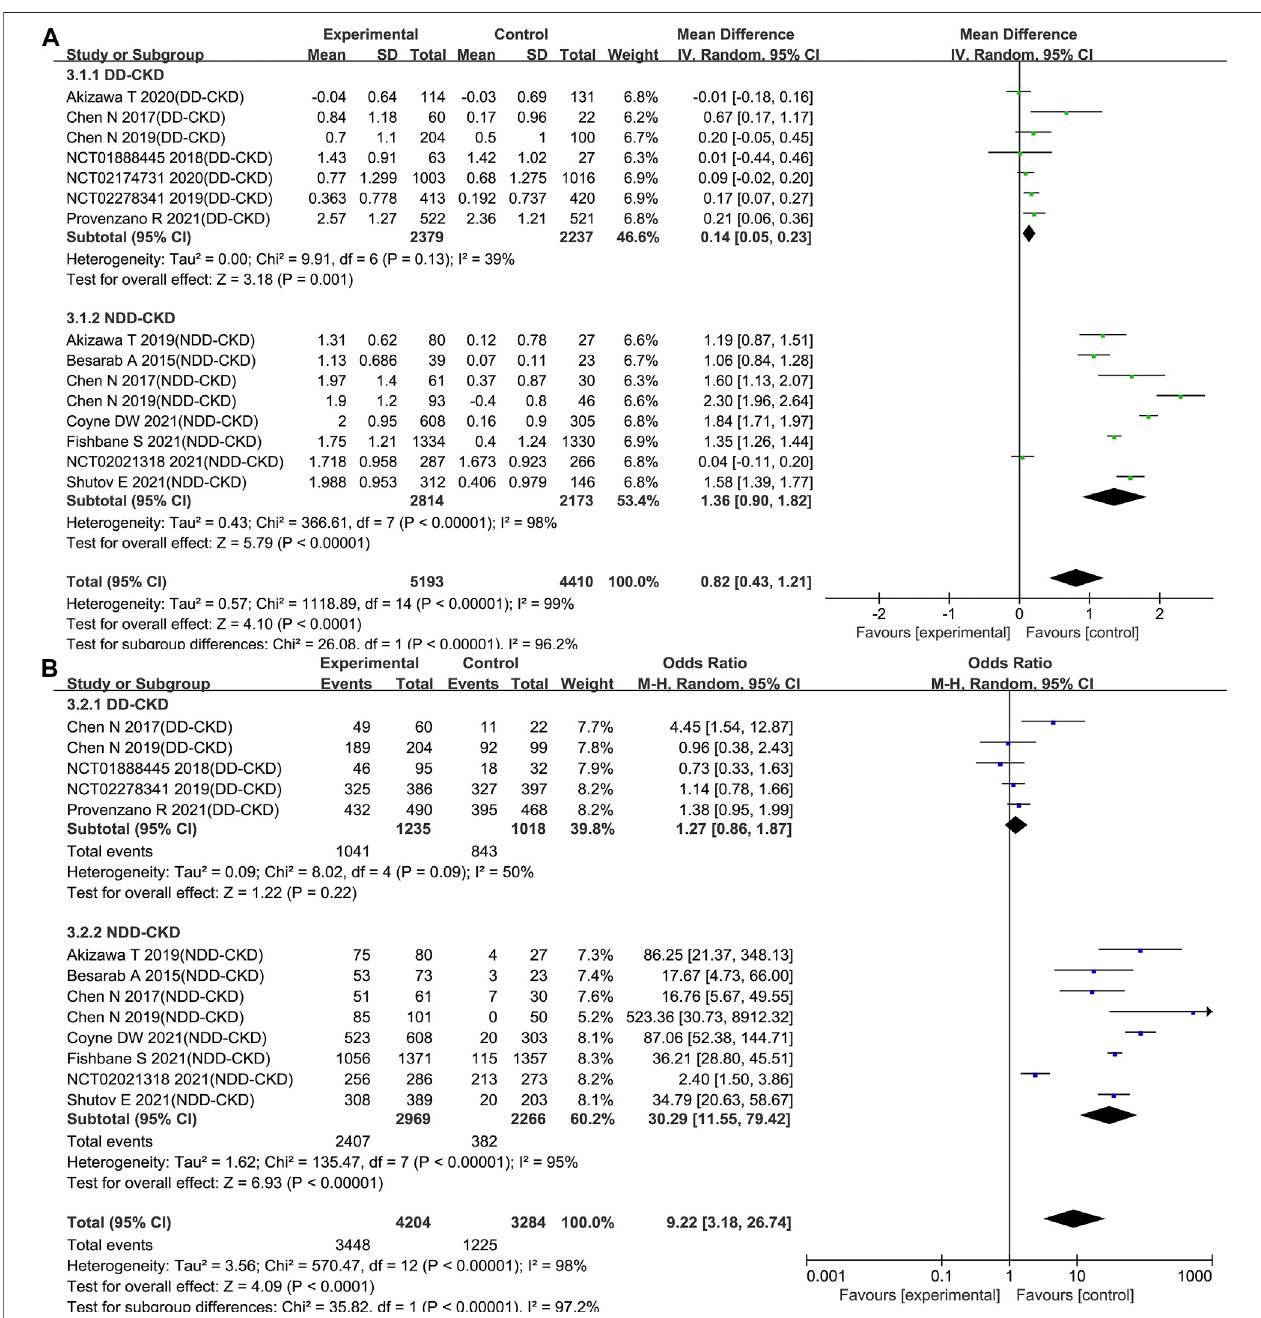
FIGURE3| EffectofroxadustatcomparedwithESAorplaceboonHblevel (A) andHbresponse (B) inCKDpatients.Notes:Hb,hemoglobin;CKD,chronickidney disease; DD-CKD, dialysis-dependent chronic kidney disease; NDD-CKD, non-dialysis-dependent chronic kidney disease.